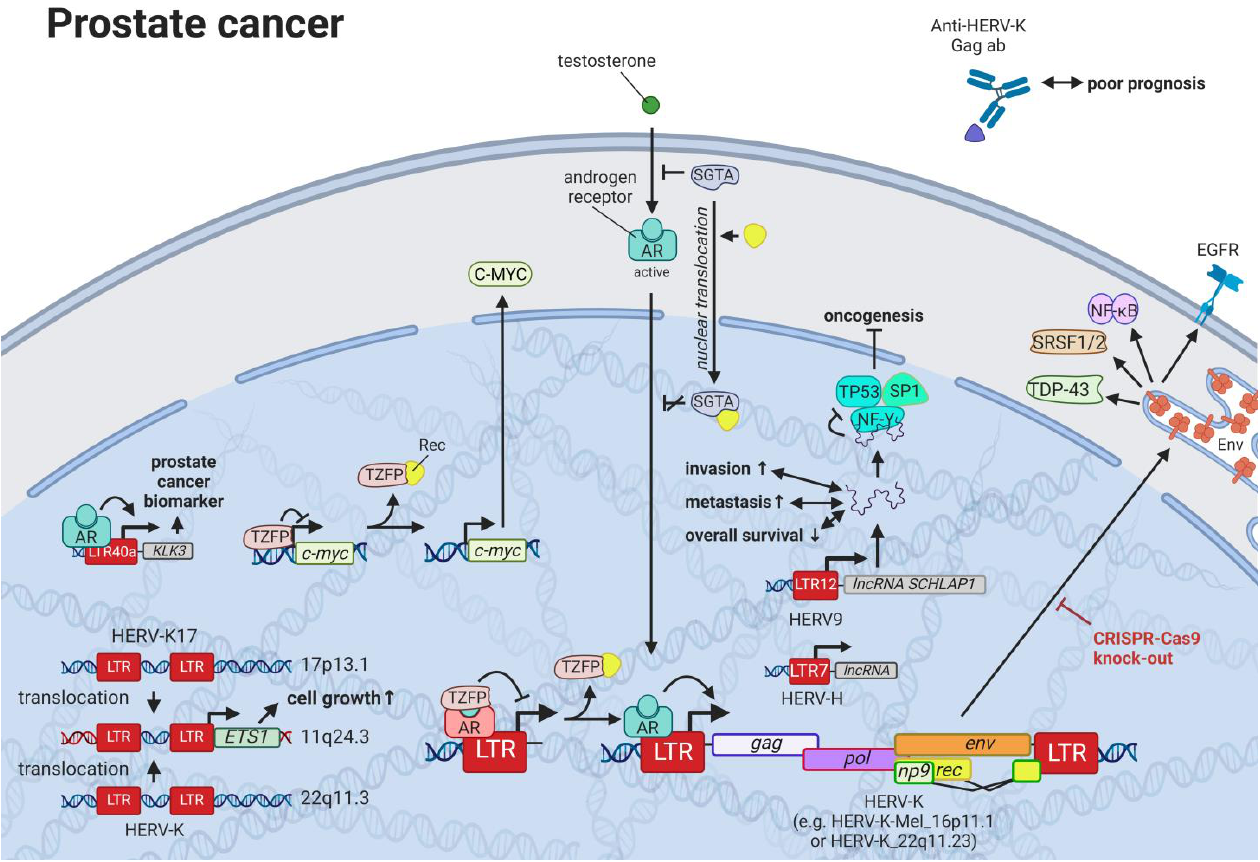
Figure 9. The role of HERVs in prostate cancer. Evaluated treatments are marked in red. Abbrevia- tions: AR = androgen receptor, ab = antibody, lncRNA = long non-coding RNA, LTR = long terminal repeat, gag = group antigen (capsid), pol = polymerase, RT = reverse transcriptase, env = envelope, HERV-K = HML-2.